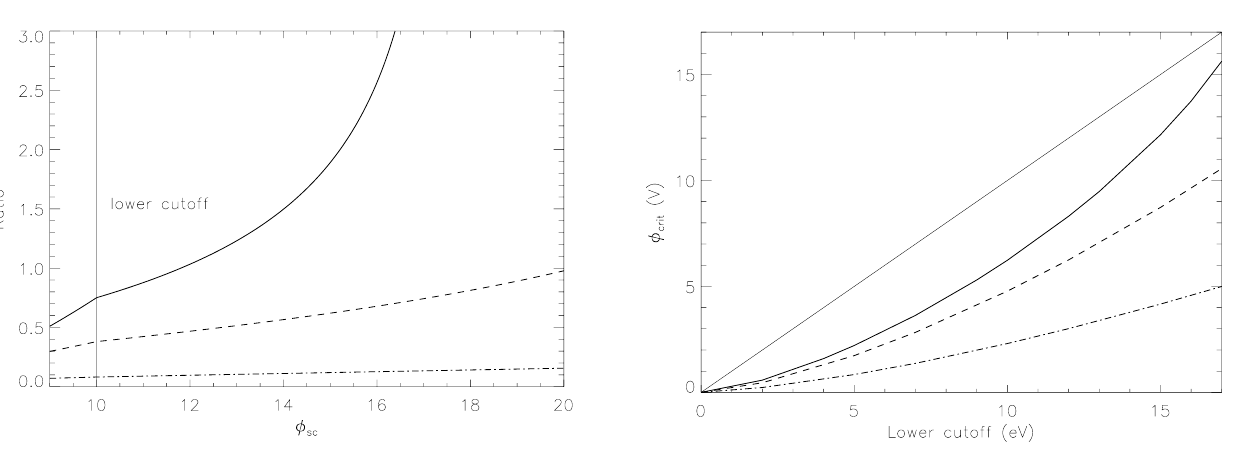
Fig. 6. Minimal density overestimation r N for potentials higher than the detector cutoff (taken here as 10eV), i.e. solar wind case (solid line), the magnetosheath case (dashed line) and the magnetosphere case (dot-dashed line).